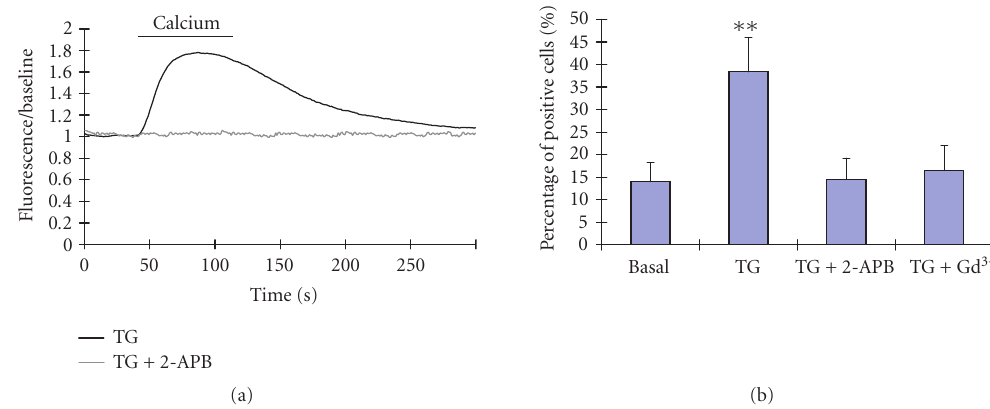
Figure 3: CRAC channel blockers prevented thapsigargin-evoked ROS production. (a) 2-APB suppressed the Ca 2+ signal induced upon readmission of external Ca 2+ . The cells were pretreated for 8 minutes with thapsigargin (2 μ M) in Ca 2+ -free solution, 20 μ M 2-APB was added just 2 minutes before the readmission of the Ca 2+ as indicated. Figure 3(a) is representative of three experiments performed on di ff erent experimental days. (b) 2-APB and Gd 3+ inhibited the ability of thapsigargin (2 μ M) to stimulate ROS production in the presence of external Ca 2+ . Three independent experiments have been performed. TG: thapsigargin. (cid:0)(cid:0) P < . 01 versus control